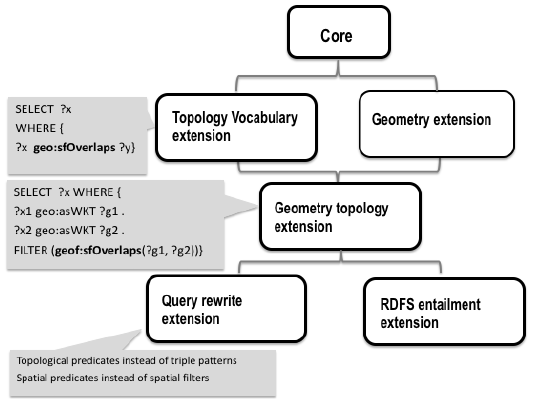
Figure 1. GeoSPARQL components